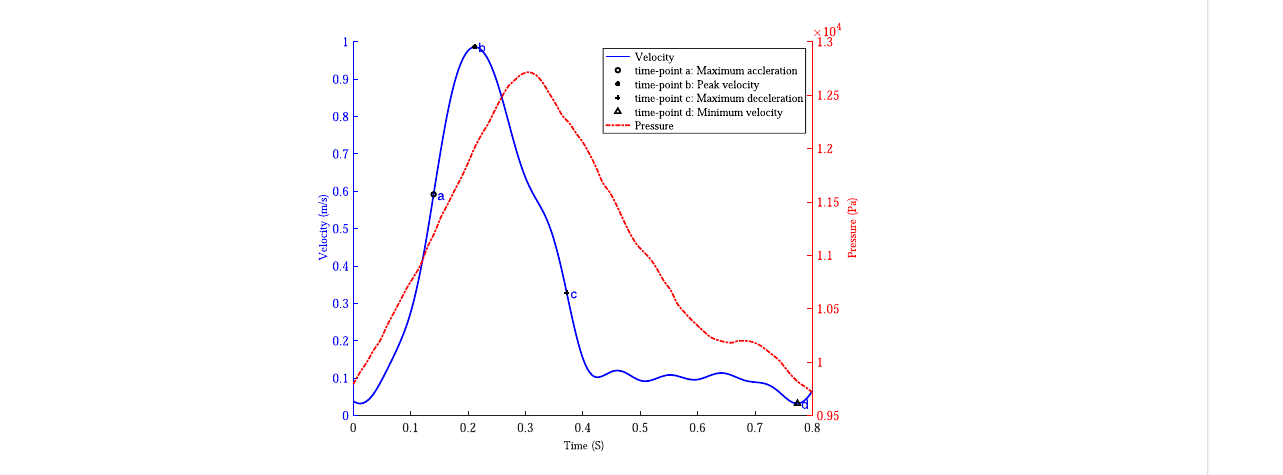
FIGURE 5 The velocity waveform at the inlet of the abdominal aorta and the pressure waveform at the outlets of the iliac arteries and four speci fi c time points were marked on the velocity pro fi